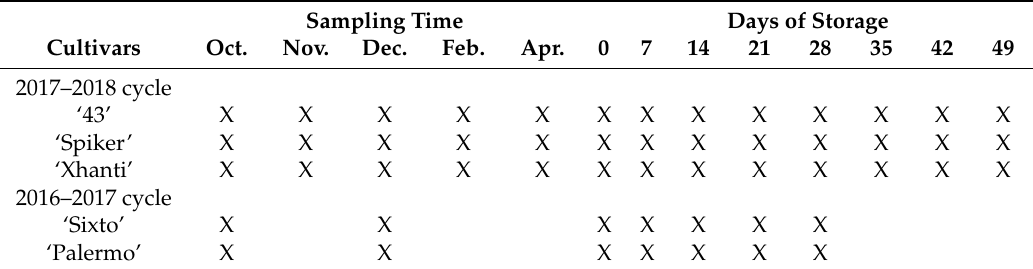
Figure 2 . Fruits of the conical Tribelli XL® pepper cultivars evaluated; ‘ Xhanti ’ cultivar (yellow fruit), ‘ 43 ’ cultivar (red fruit), and ‘ Spiker ’ cultivar (orange fruit). Figure 3 . “ Italian sweet ” red pepper fruits evaluated. ‘ Sixto ’ cultivar (A) and ‘ Palermo ’ cultivar (B). Table 1 . Sampling for each crop cycle and month of evaluation and days in which the samples of each tomato, cucumber, and pepper cultivar were measured in the laboratory.